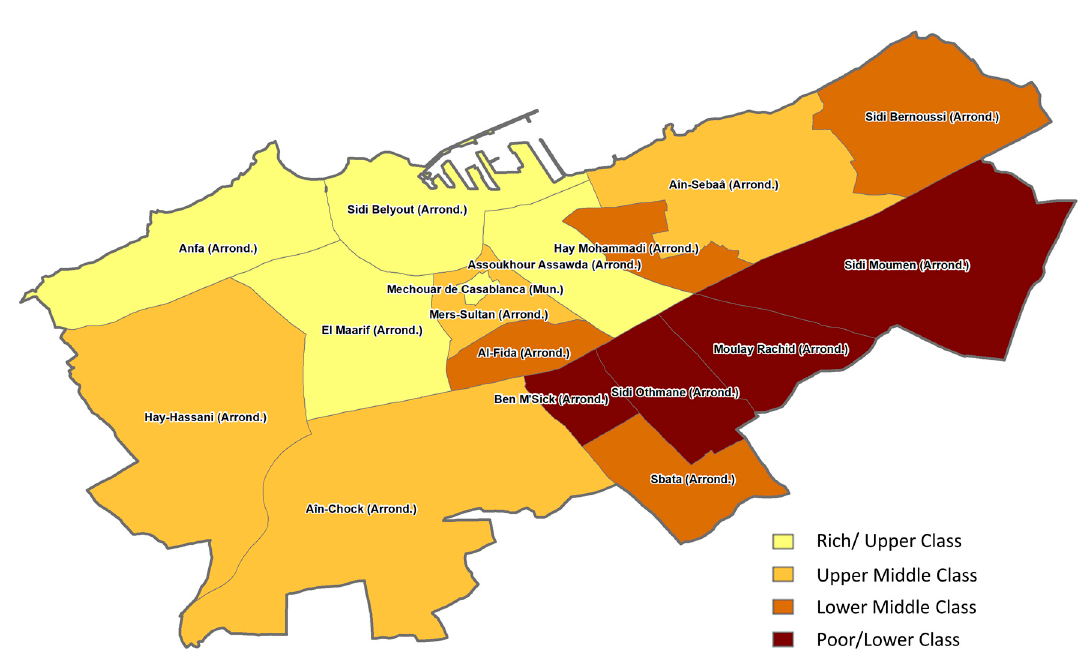
Figure 17. Localization of middle class in Casablanca City.